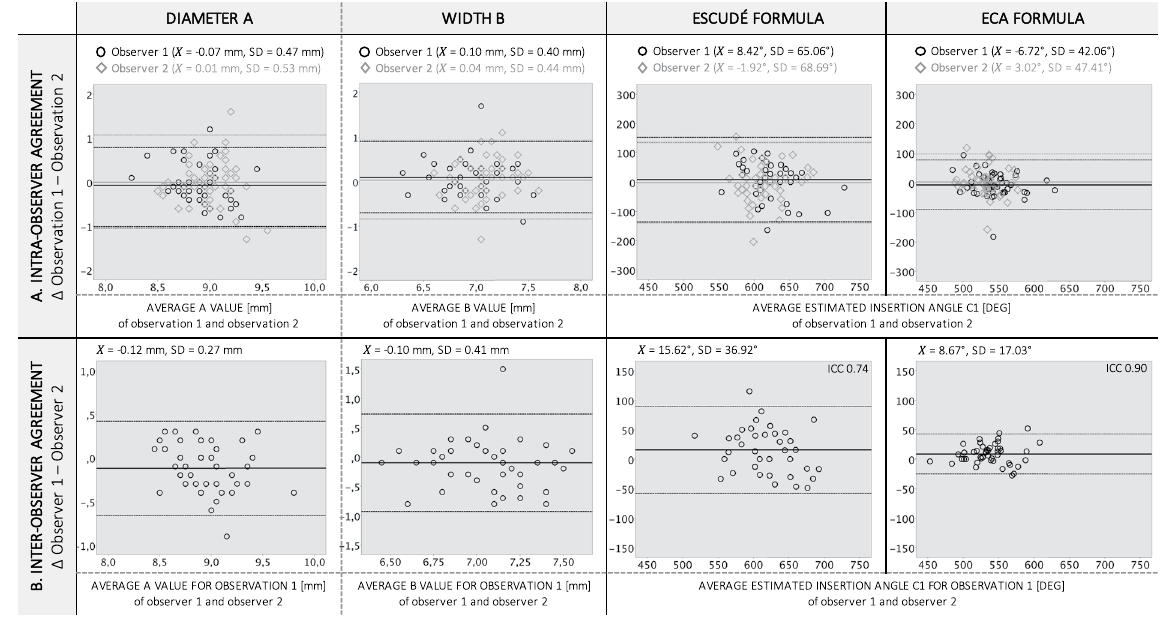
Figure 6. Bland-Altman plots of the intra -and inter-observer agreements for the preoperative A and B measurements and the predictions of the electrode insertion angles, using the adopted Escudé approach and ECA. ( A ) INTRA-OBSERVER AGREEMENT. For each preoperative measurement the differences between observation 1 and observation 2 are shown against the respective averages of both observations. Data from observer 1 are displayed in black and from observer 2 in grey. The solid lines represent the mean differences between both observations. The top dotted lines show the upper 95% limit of agreement, and the bottom dotted lines show the lower 95% limit of agreement (2STDEV). ( B ) INTER-OBSERVER AGREEMENT. For each preoperative measurement the differences between observer 1 and observer 2 for their first observation are shown against the respective averages of both observers. The solid lines represent the mean differences between both observers. The top dotted lines show the upper 95% limit of agreement, and the bottom dotted lines show the lower 95% limit of agreement (2STDEV).